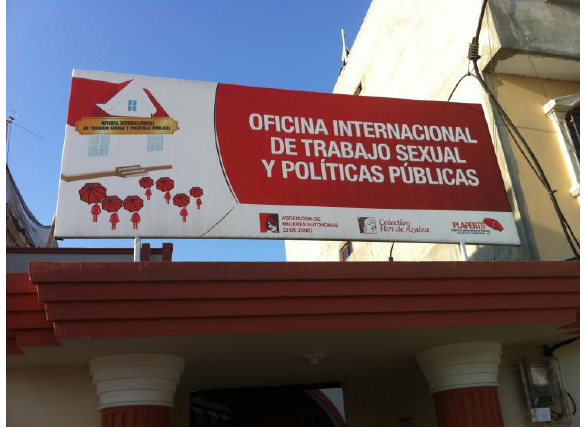
Figure 4. Latin American Platform of People Who Exercise Sex Work (PLAPERTS) headquarters in Machala. Sign reads, “International Office of Sex Work and Public Policies.” The logos at the bottom, from left to right, are for the Association of Autonomous Female Workers “22nd of June”, Collective Flor de Azalea, and PLAPERTS. Photo by author.